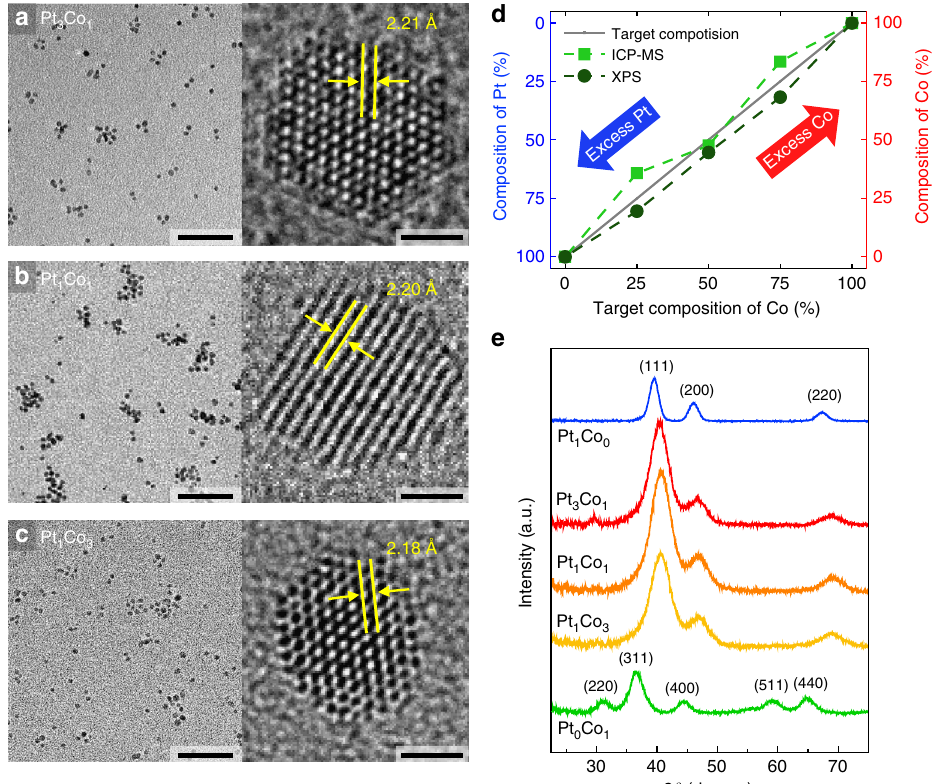
Fig. 2 Structural and chemical characterization of PtCo bimetallic NPs. TEM and high-resolution TEM (HRTEM) images of as-synthesized a Pt 3 Co 1 , b Pt 1 Co 1 , and c Pt 1 Co 3 bimetallic NPs. Scale bars are 30 nm (left) and 1 nm (right) ( a – c ). d Comparison of the composition values of the Pt x Co y bimetallic NPs obtained from XPS and ICP-MS, which generally agree well with the targeted molar ratio of the Co and Pt precursors. e XRD patterns of Pt 1 Co 0 (blue), Pt 3 Co 1 (red), Pt 1 Co 1 (orange), Pt 1 Co 3 (yellow), and Pt 0 Co 1 (green)